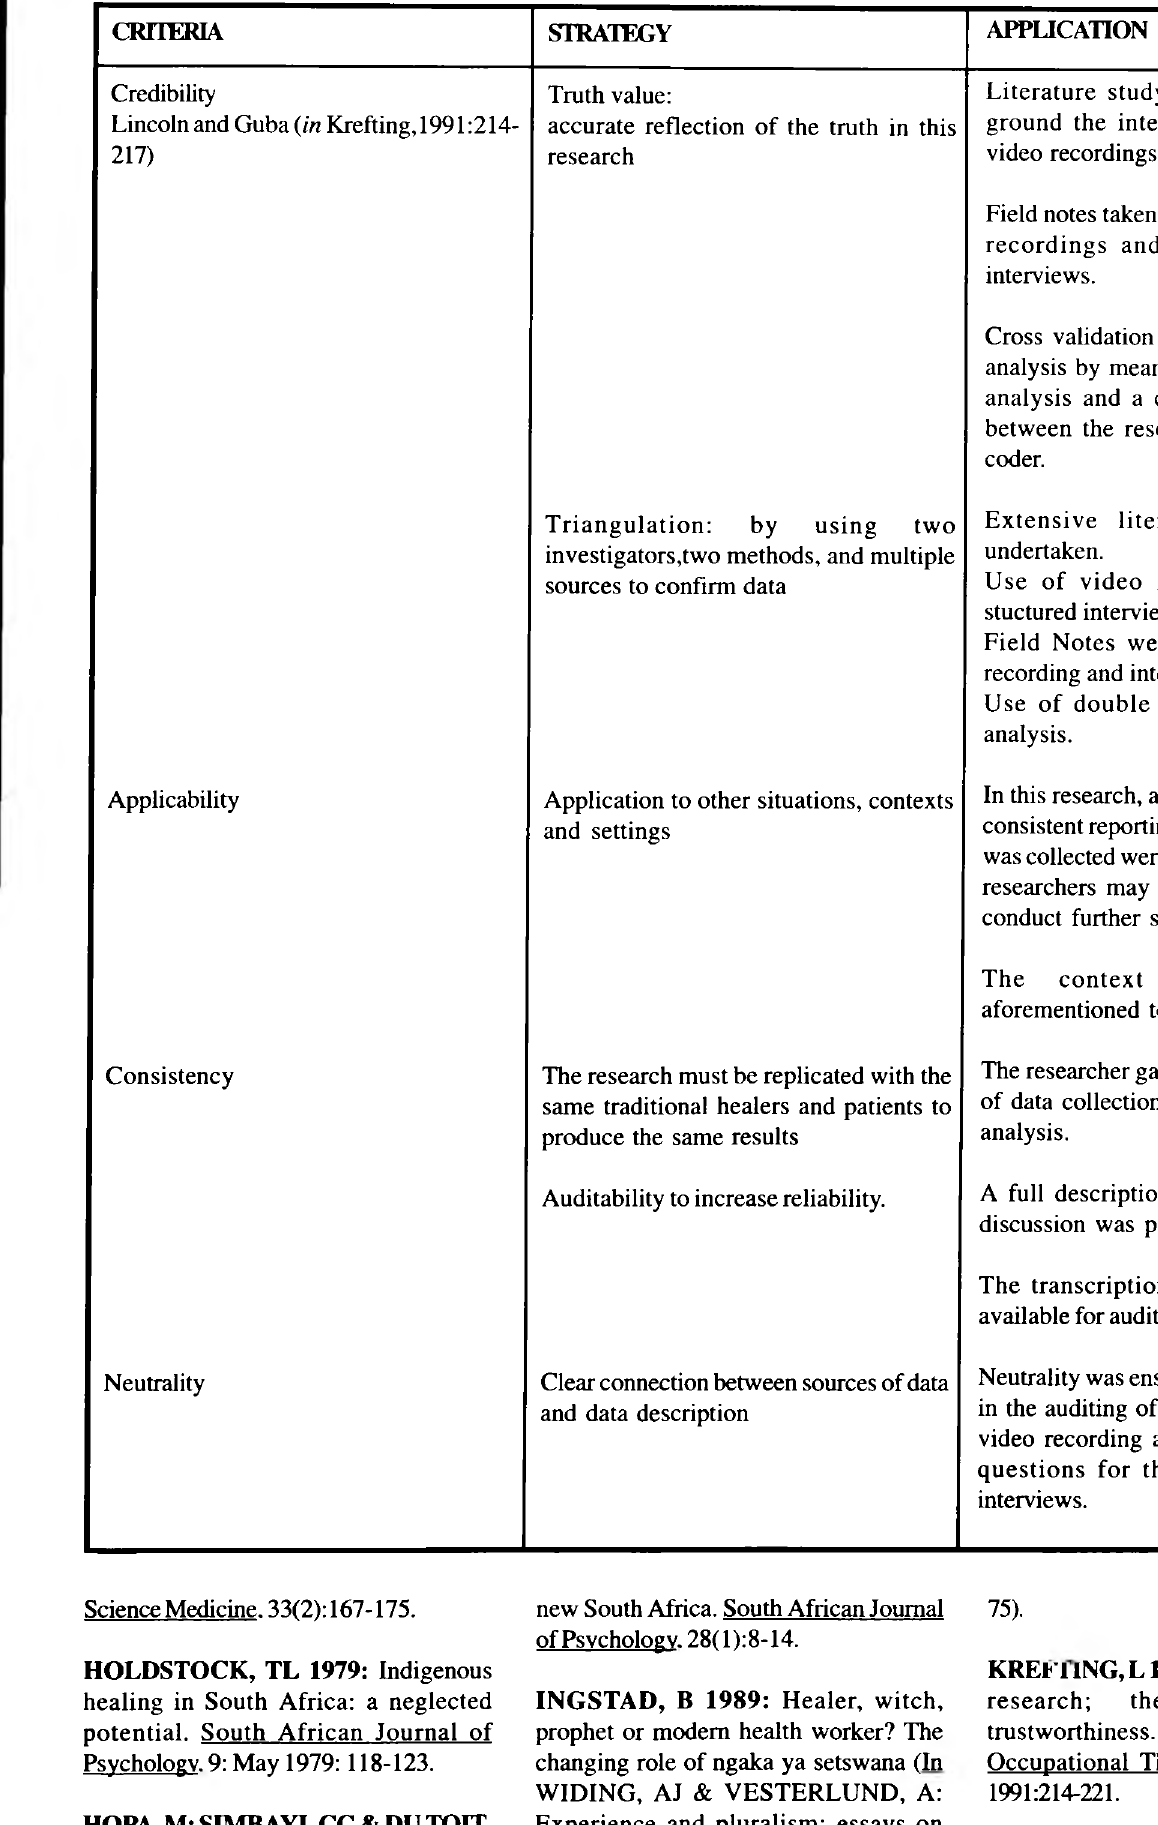
Table 1 Measures for